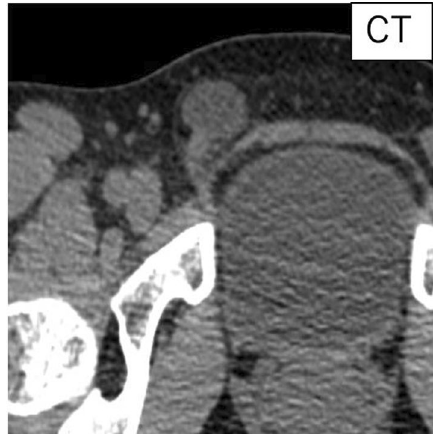
20 mm × Fig. 6 TEP ports placement after intraperitoneal observation. A 10 mm port at the umbilicus, 5 mm port above the pubis,